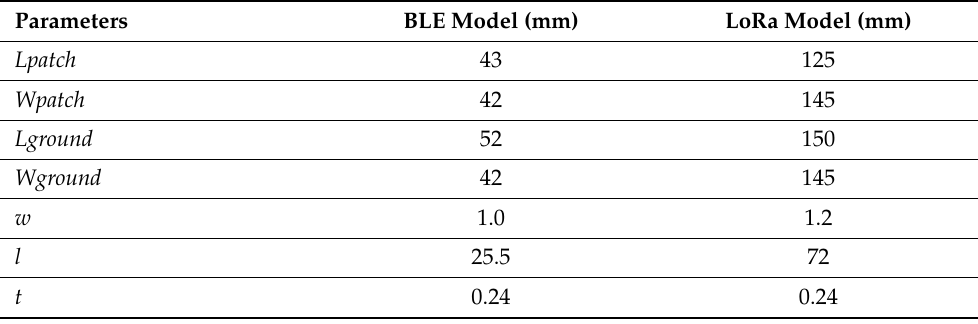
Table 2. Parameter List for Aperture-Fed Antenna.